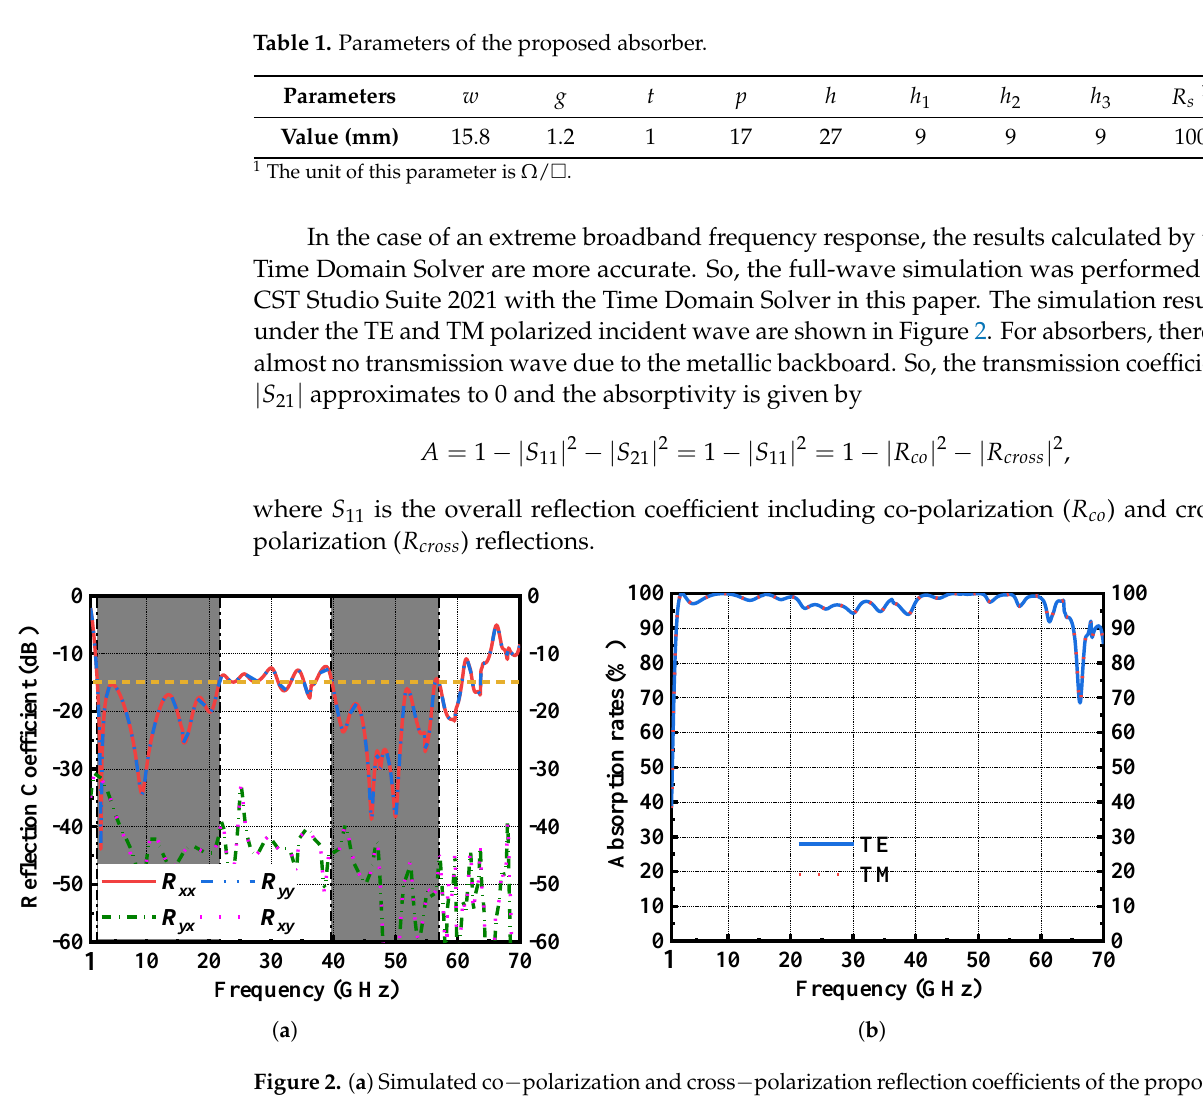
Figure 2. ( a ) Simulated co − polarization and cross − polarization reflection coefficients of the proposed absorber under normal incident wave with x and y polarization. ( b ) Corresponding absorption